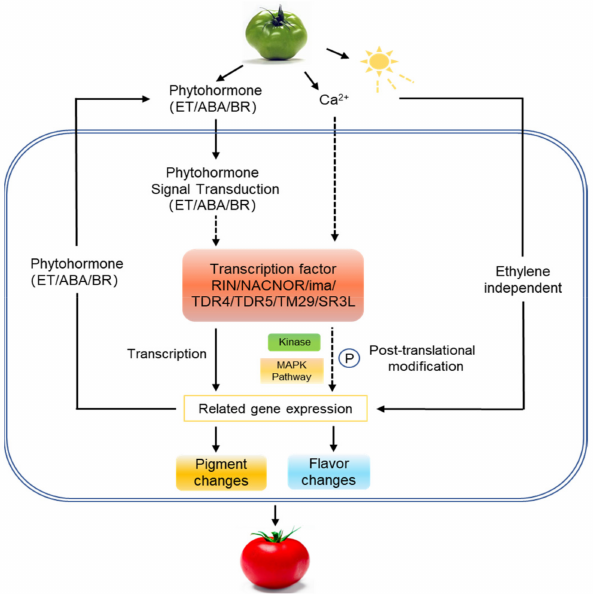
Figure 12. An overview of the fruit-ripening network examined in this study. The ripening of fruit is a process of the co-regulation of plant hormones, light, Ca 2+ and other factors. These factors can influence the regulation of the expression of transcription factors of related functional genes through phosphorylation modification, influencing the activity of fruit-ripening-related proteins, and thereby regulate the fruit-ripening